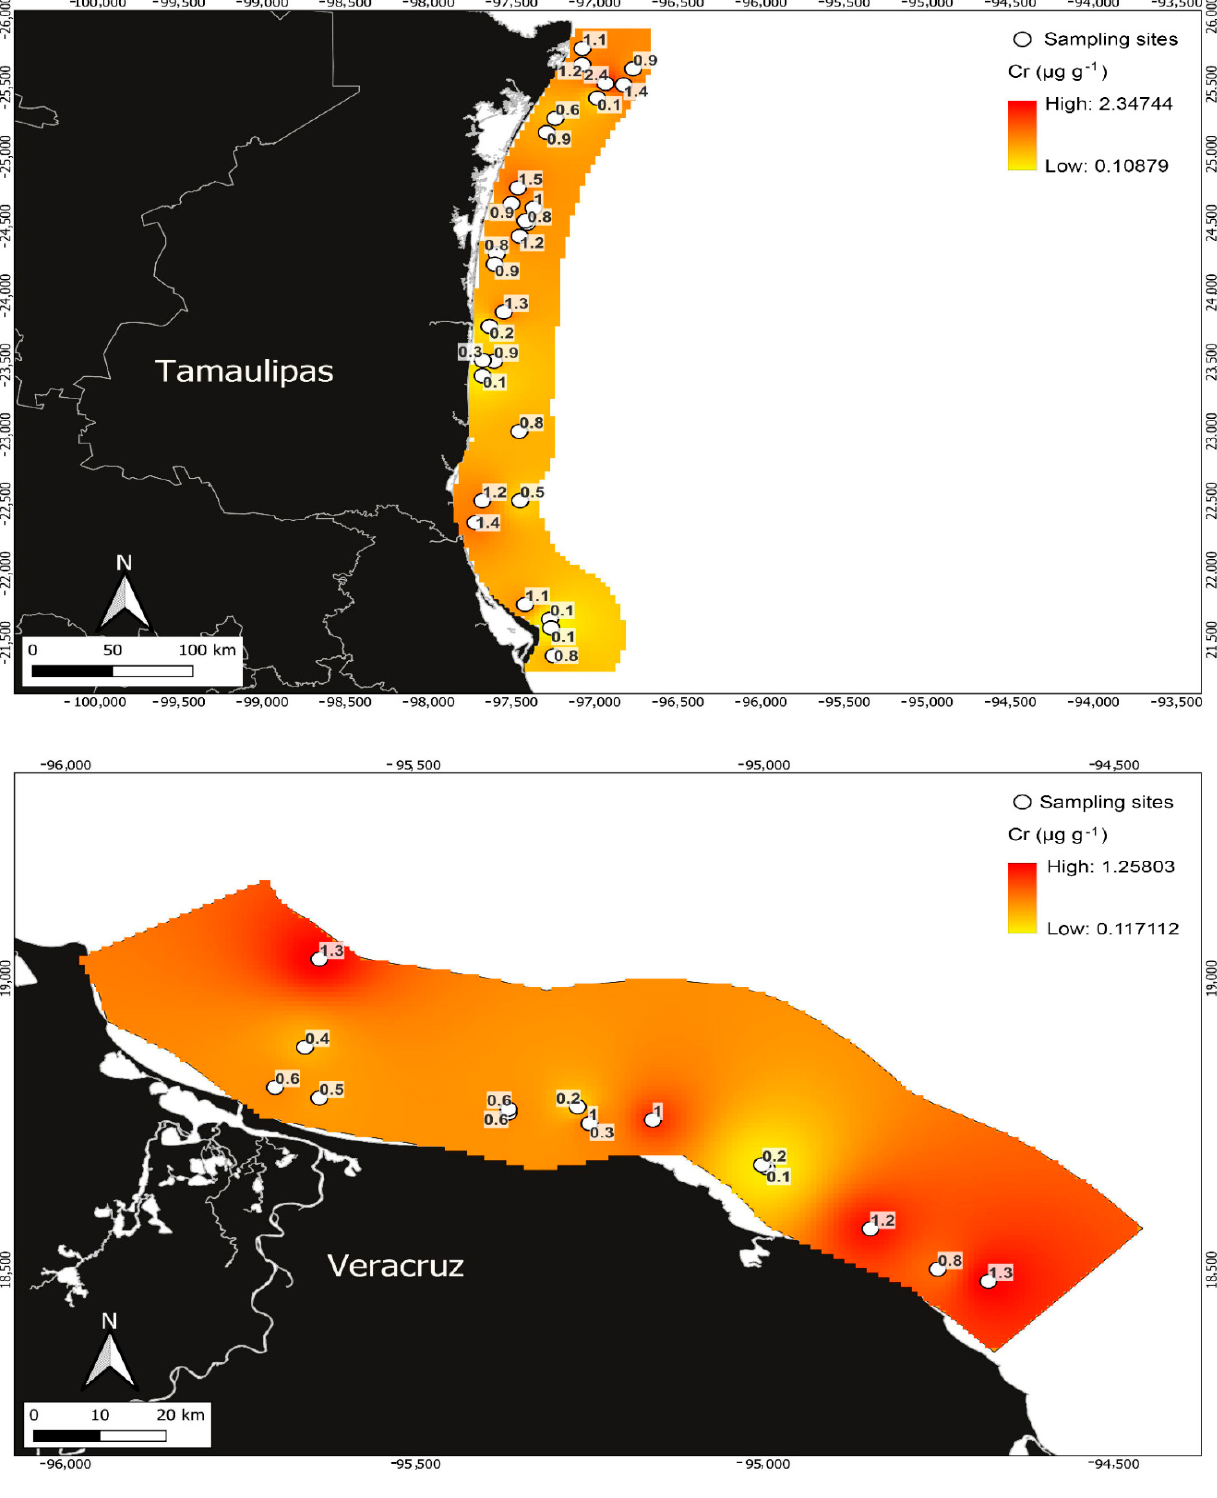
Figure 6. Cr concentrations in Penaeus aztecus shrimp (whole body) in the areas of Tamaulipas ( up- per ) and Veracruz ( below ), Mexico. and Veracruz ( below ),